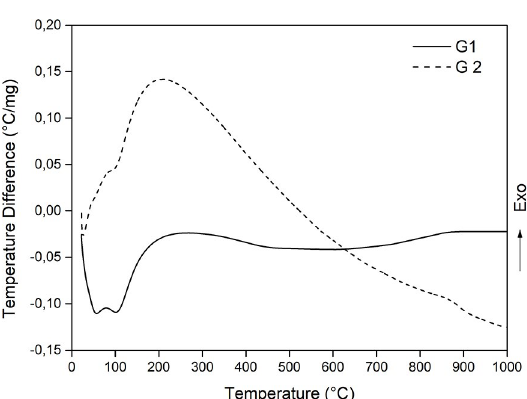
Figure 8. DTA curves of G1 and G2.